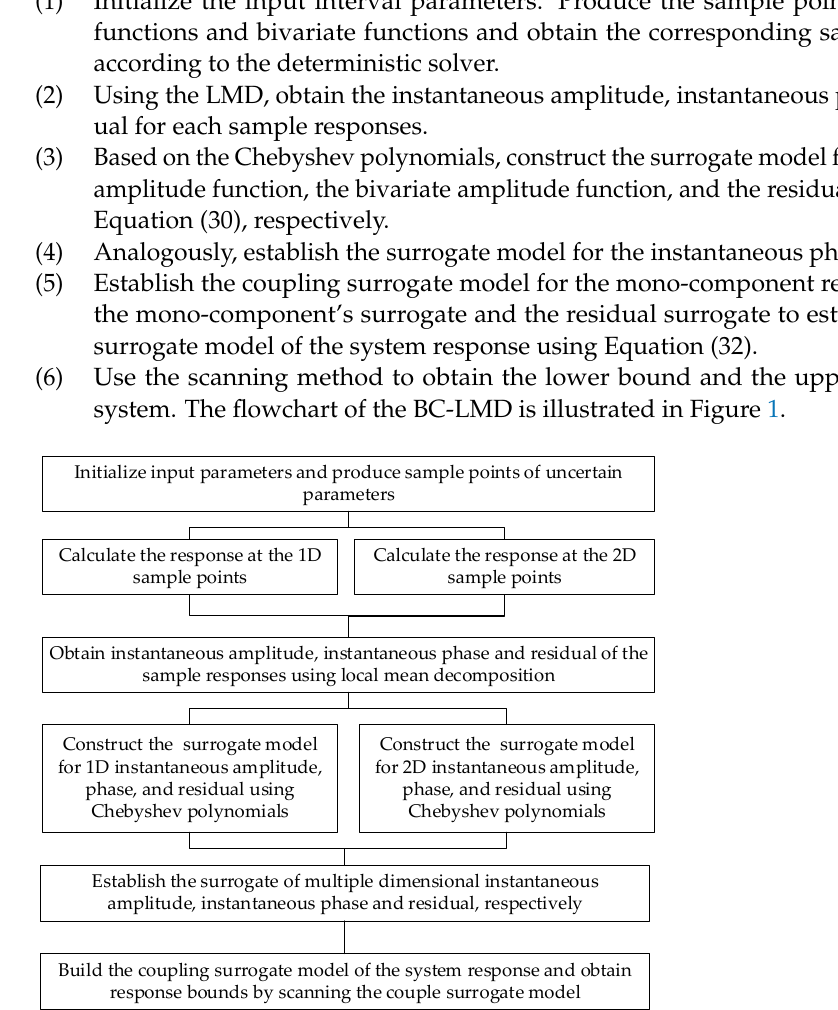
Figure 1. Flowchart of BC-LMD.